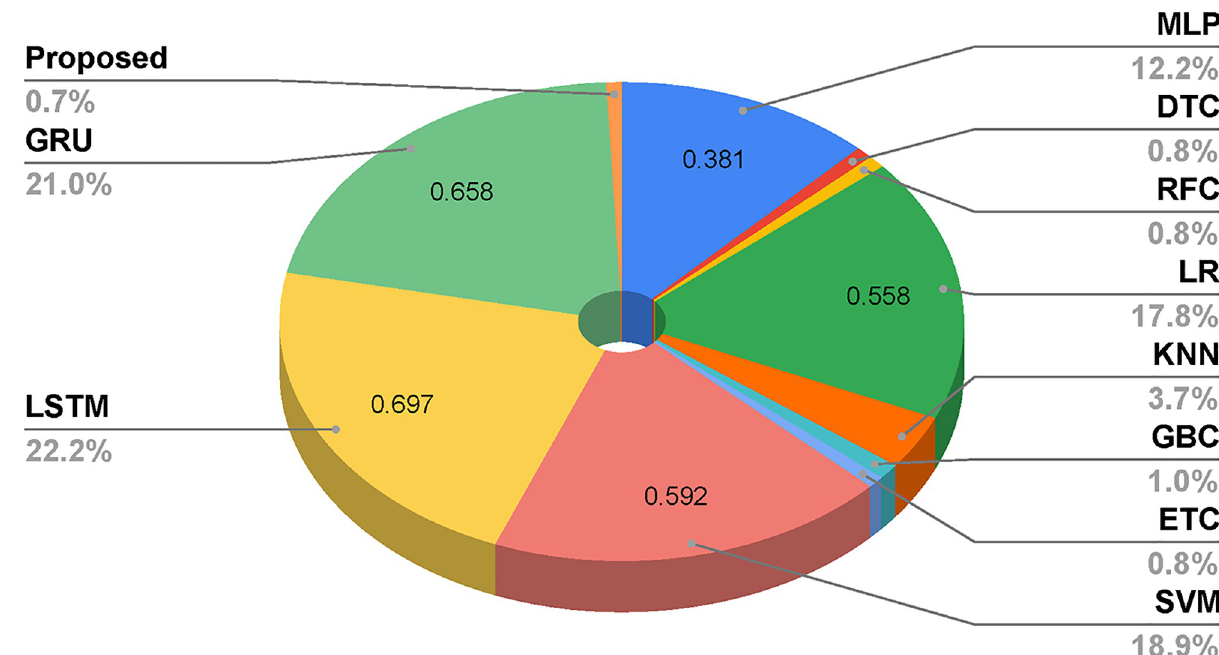
Fig 8. Comparative analysis of employed machine learning and deep learning models in terms of prediction error rate.